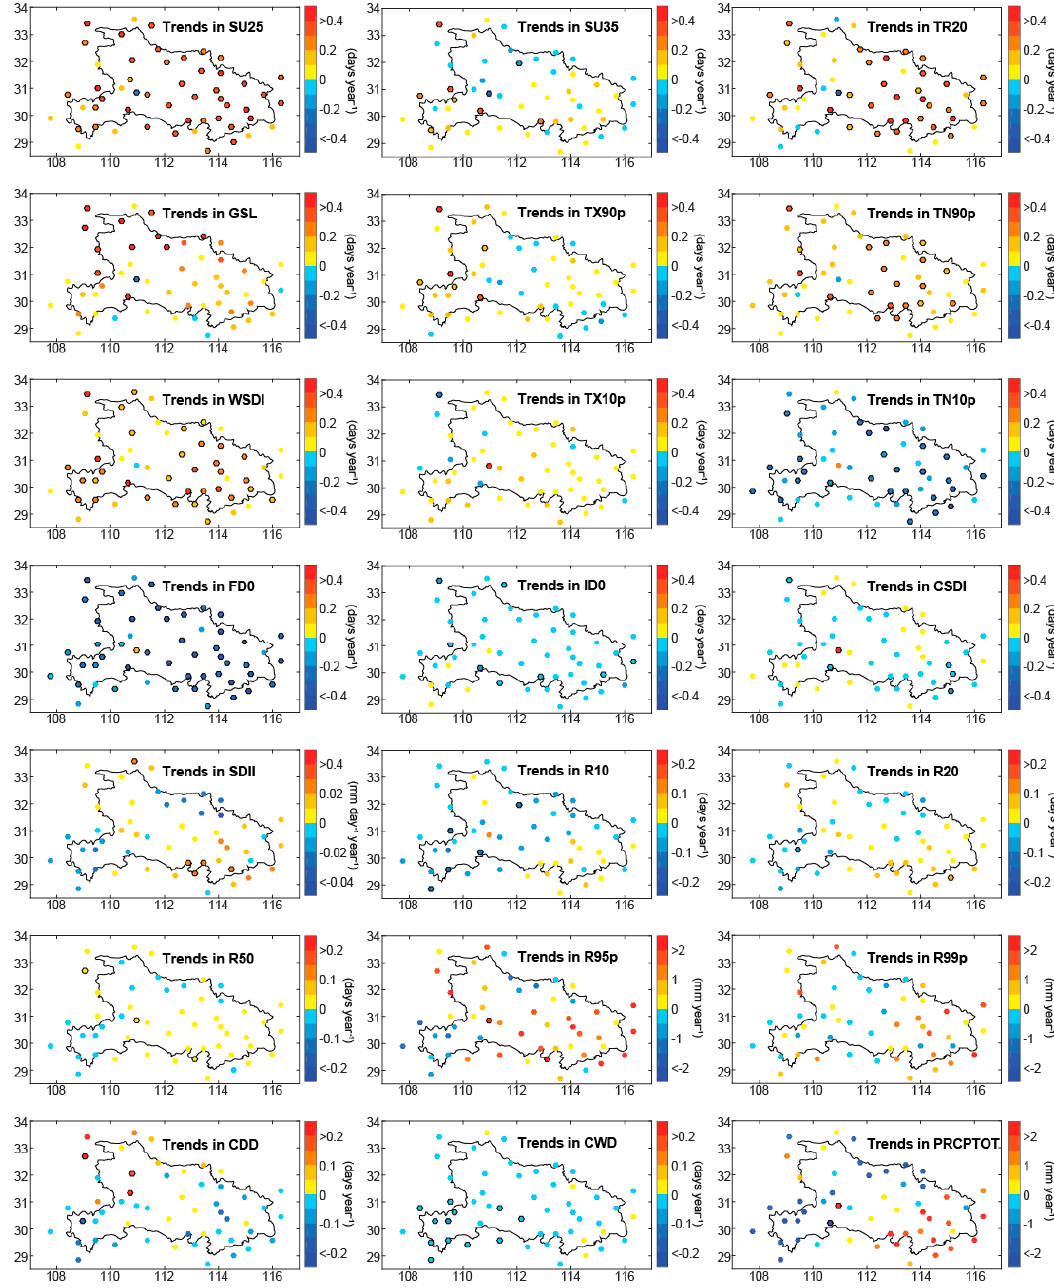
Figure 2. Temporal trends in temperature and precipitation indices from 1961 to 2015 at the 52 meteorological stations distributed across Hubei Province. The colored dots represent the magnitude of the trends, and the black outlines indicate the significance at the p < 0.05 level.